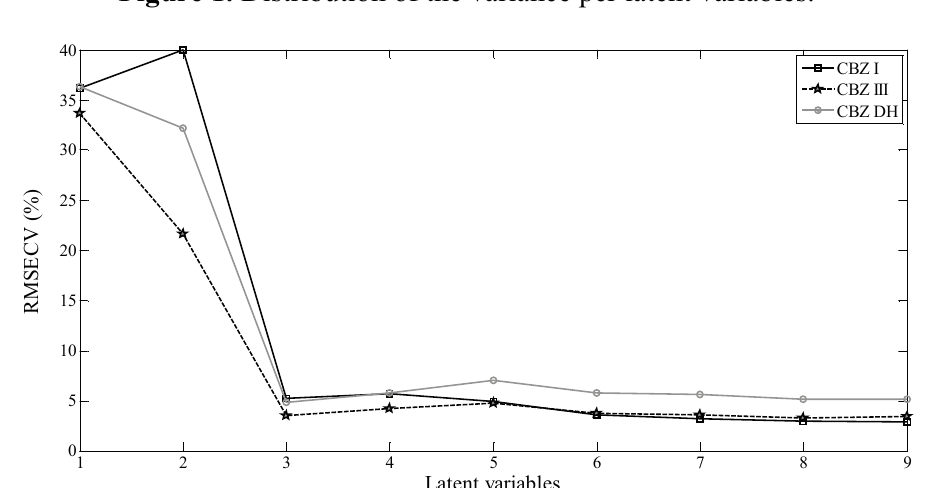
Figure 1. Distribution of the variance per latent